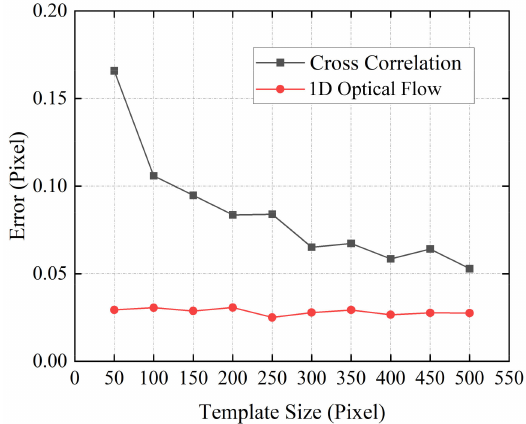
Figure 5. Dependence of the average error of displacement estimation on the template size for different algorithms.